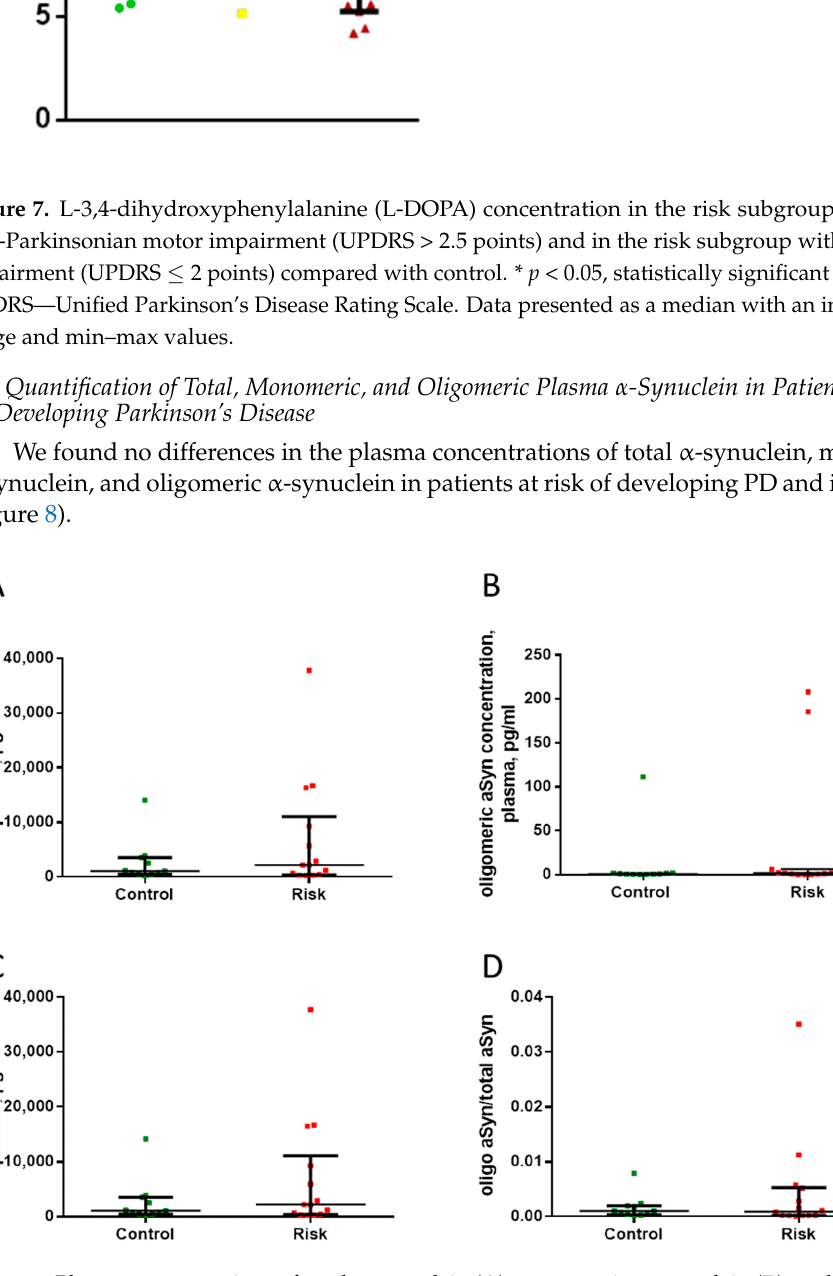
Figure 8. Plasma concentrations of total α -synuclein ( A ), monomeric α -synuclein ( B ), and oligomeric α -synuclein ( C ), as well as the ratio of oligomeric α -synuclein to total α -synuclein ( D ) in the patients at risk of developing Parkinson’s disease and in the controls. Data presented as a median with an interquartile range and min–max values. 2.4. Dopamine receptor genes in lymphocytes.